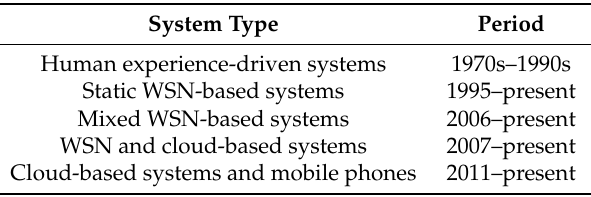
Table 1. Evacuation wayfinding